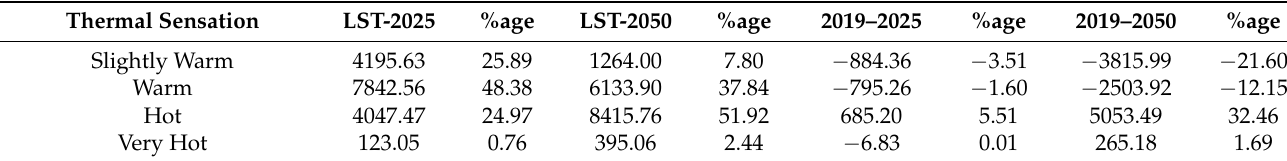
Table 6. Statistics of the predicted area (km 2 ) under temperature ranges for 2025 and